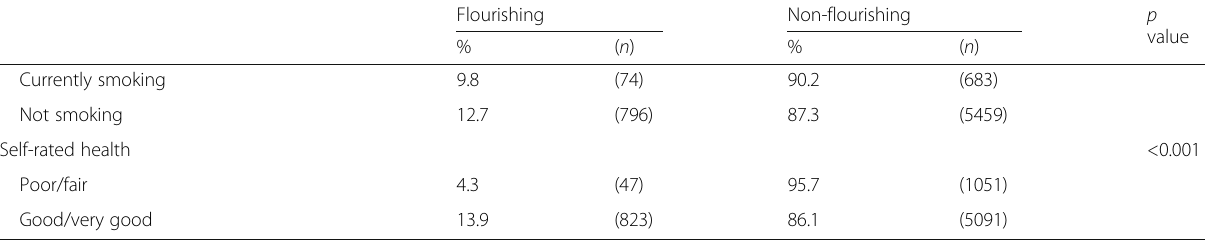
SD standard deviation Statistical analyses were conducted with chi-squared test and t